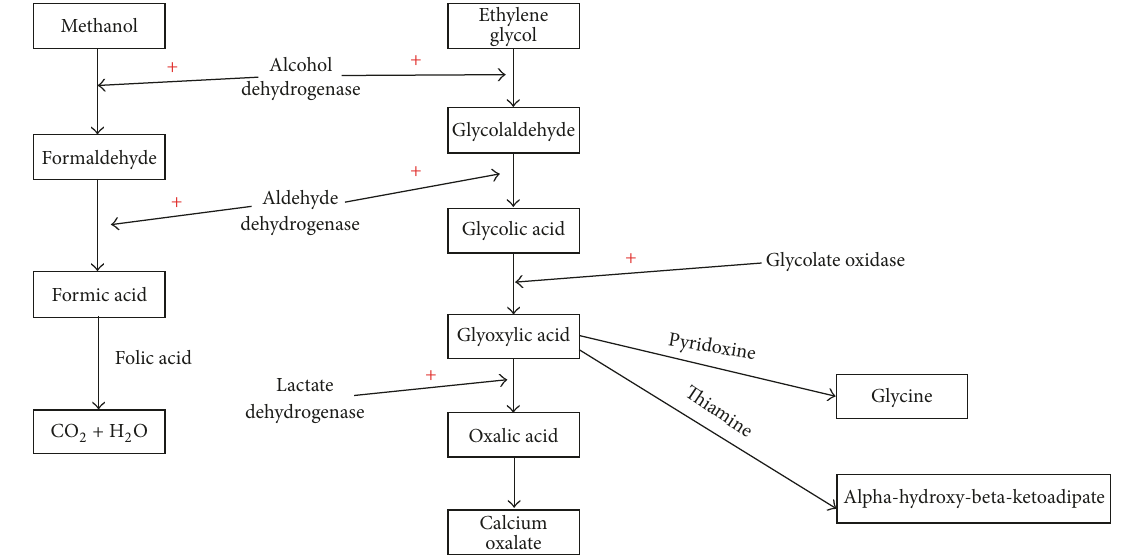
Figure 3: An overview of in vivo methanol and ethylene glycol